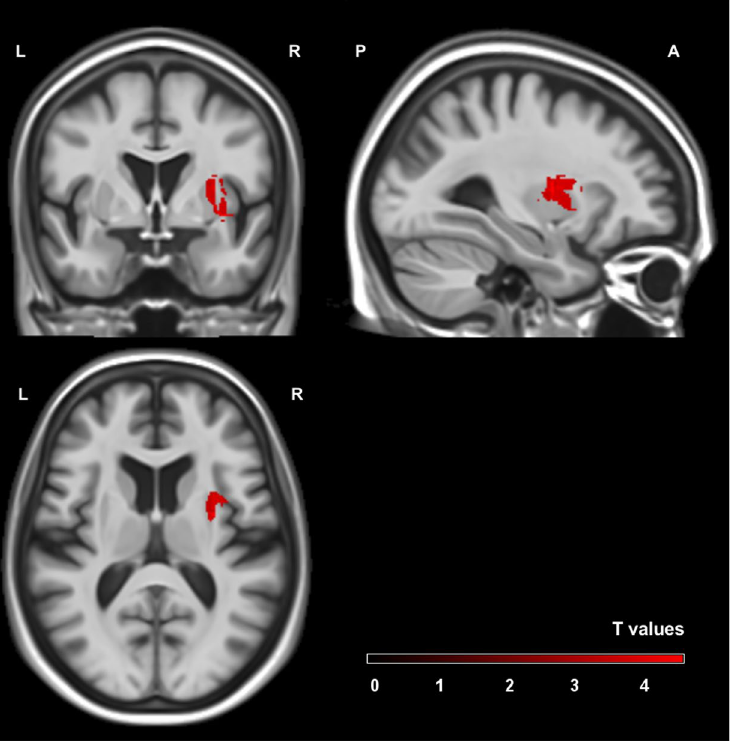
Figure 4. Cluster of the exploratory voxel-based lesion symptom mapping analysis. The area is significant with a voxel threshold of p < 0.01. Scale bars represent t-scores. L: left hemisphere, R: right hemisphere, A: anterior, P: